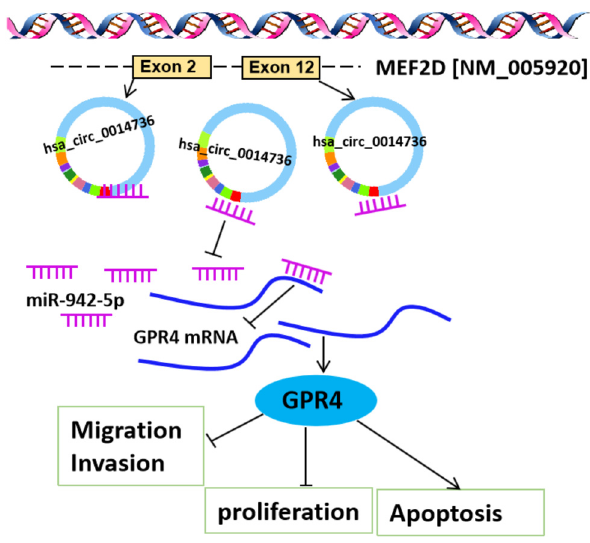
Figure 7: Schematic diagram showed the mechanism of circ_0014736 regulating human placental trophoblast cell dys - function in